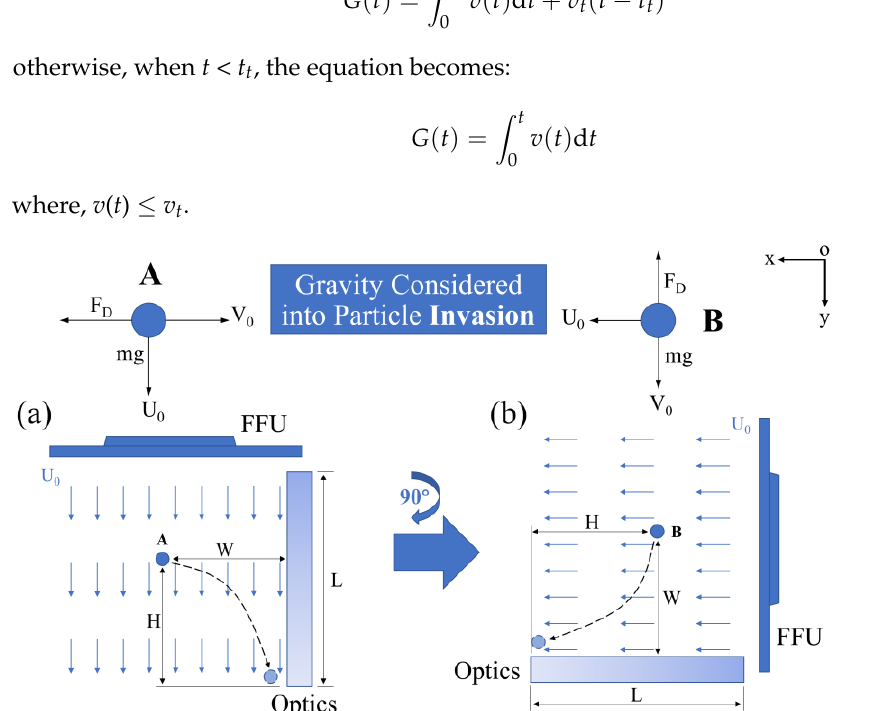
Figure 2. Two methods preventing particulate invasion by laminar flow, ( a ) avoid direct impact for particles with a longitudinal velocity of V 0 ; ( b ) sedimentation control after V 0 decreases to 0.